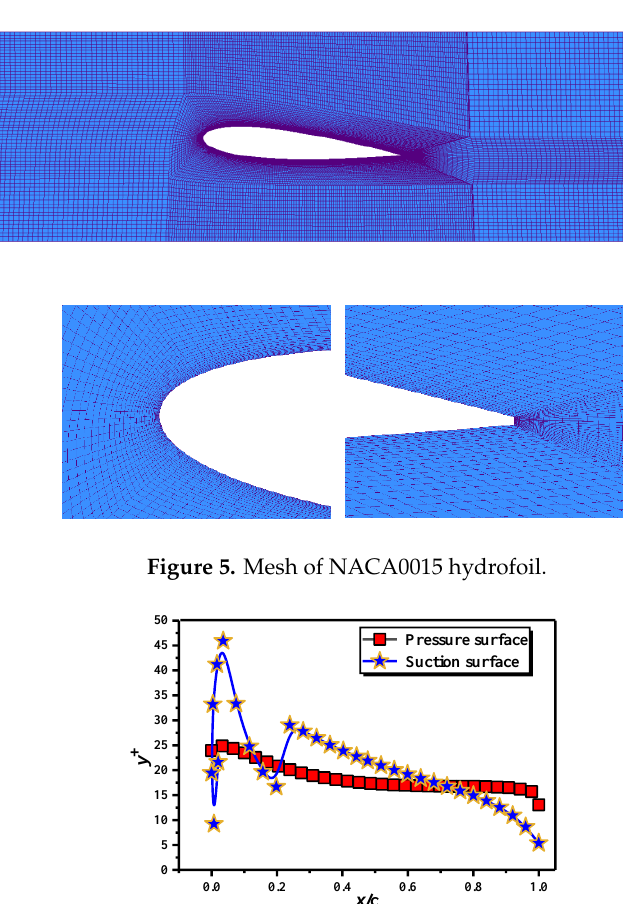
Figure 6. y + distribution of NACA0015 hydrofoil.